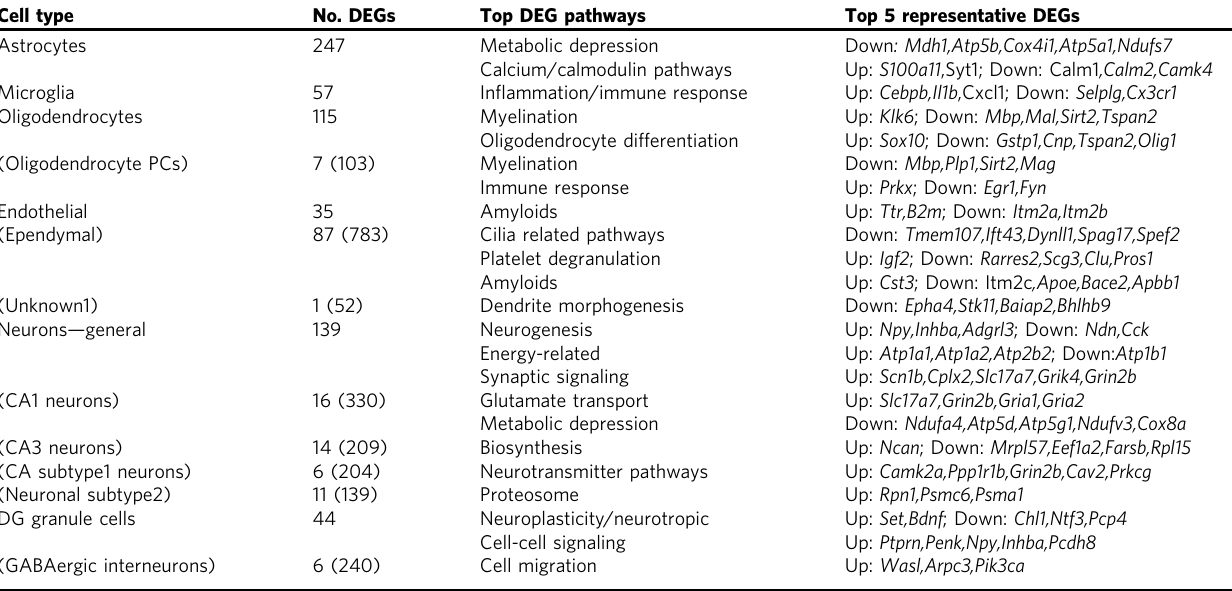
Table 1 Top enriched pathways among DEGs of major cell types (FDR<5%) and representative DEGs in the select pathways Cell